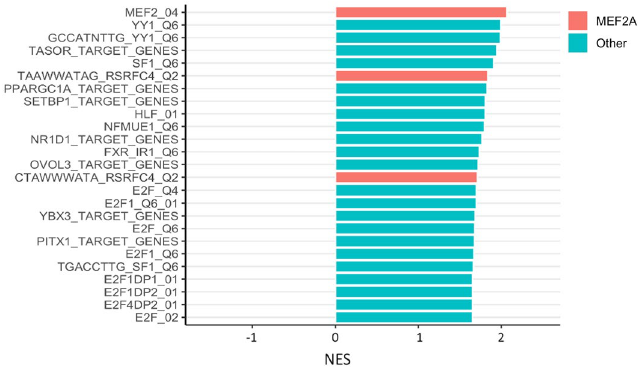
Figure 5. Top 25 transcription factor target gene sets significantly enriched in GSEA (P adj < 0.05) ranked by NES (normalised enrichment score). Gene sets with a positive NES are enriched by genes with skeletal muscle baseline expression positively correlated to ΔS i while genes with a negative NES are enriched by genes with skeletal muscle baseline expression negatively correlated to ΔS i . Sets corresponding to MEF2A target genes are highlighted in red. A full list of significant transcription factor target gene sets is available on Supplementary Table S3.